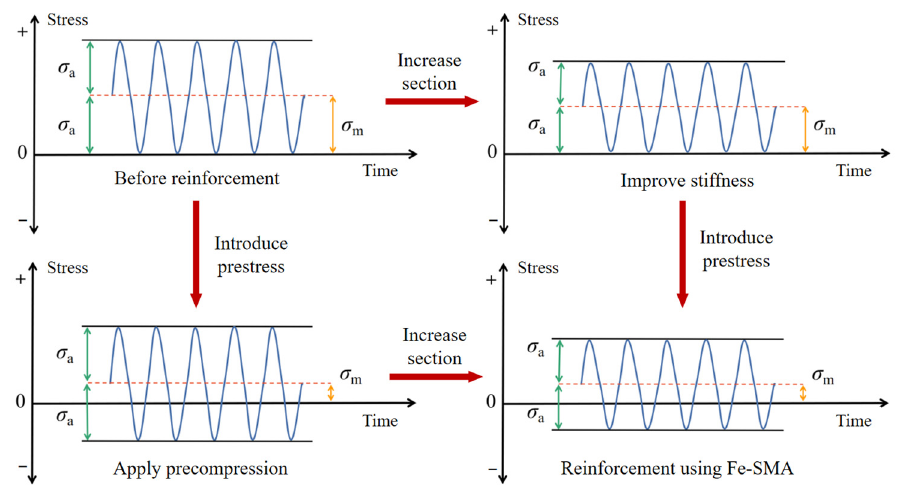
Figure 8 . Effect of repairing fatigue cracks with Fe-SMA. Figure 8. Effect of repairing fatigue cracks with Fe-SMA. Table 5. Recovery stresses of Fe-SMA under different activation